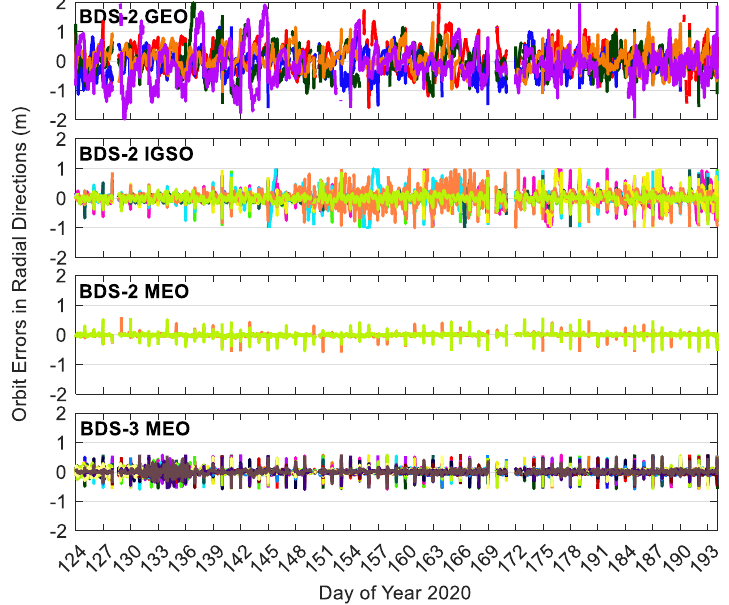
Figure 8. Radial errors of BDS-3/BDS-2 precise satellite orbits in the real-time situation. Different colors in the figure refer to different satellites.